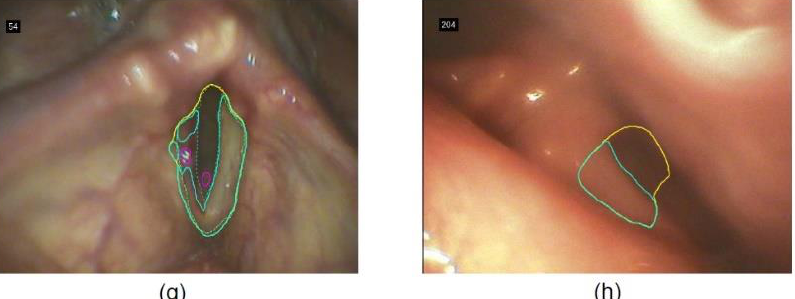
Figure 5. Examples of segmentation results in the test set across different videos: ( a – c ) high overlap between references (dotted) and AI-based (drawn through) segmentation in different states (open, closed) and light conditions, ( d ) segmentation errors of partially visible glottis close to the image edge, ( e ) correct detection of aspiration, ( f ) missed detection of aspiration, ( g ) false-positive detection of aspiration, ( h ) false-positive segmentation of glottis and vocal cords on frame without visible glottis. Solid lines denote the automatic segmentation (yellow: glottis ROI, cyan: vocal cords, magenta: detected aspiration), dotted lines the reference segmentation. Numbers in the upper left corner denote the index of the frame in the test set.